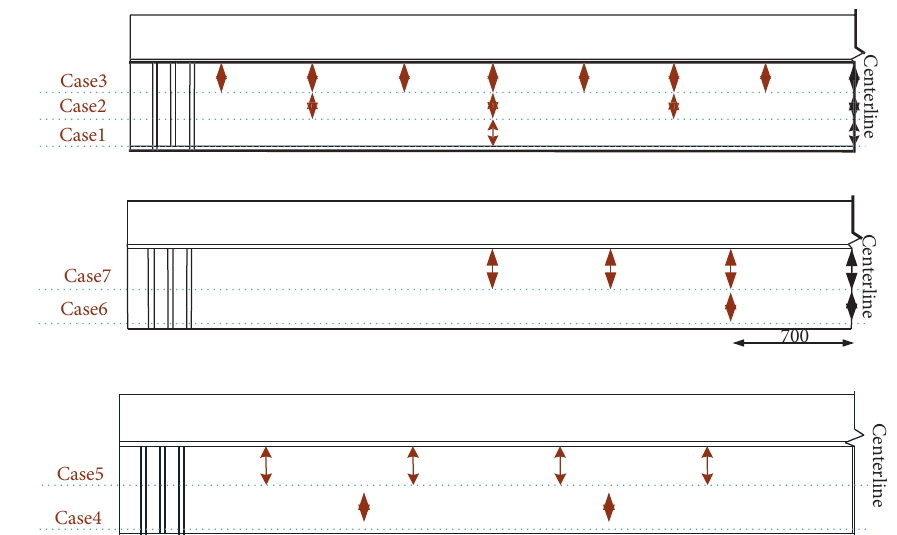
Figure 14: Various layouts of the ribs.